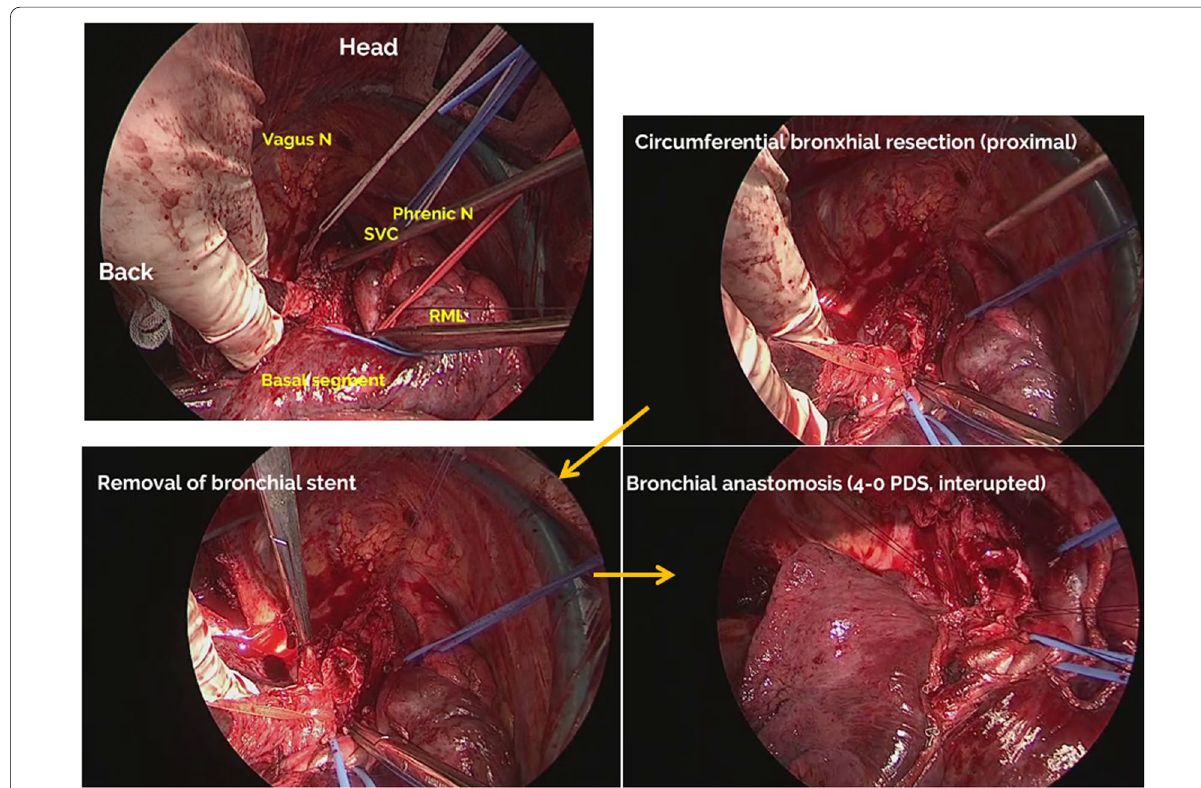
Fig. 4 Through posterolateral thoracotomy, pulmonary vessels were divided and standard nodal dissection was completed. Then, right main bronchus and bronchus intermedius were exposed (left upper). Proximal transection of the main bronchus was performed (right upper), and the bronchial stent was removed (left lower). After distal transection of the bronchus intermedius and pathological confirmation of no malignant cells at the proximal and distal bronchial stumps, the bronchial ends were anastomosed end-to-end with interrupted 4–0 polydioxanone sutures (right